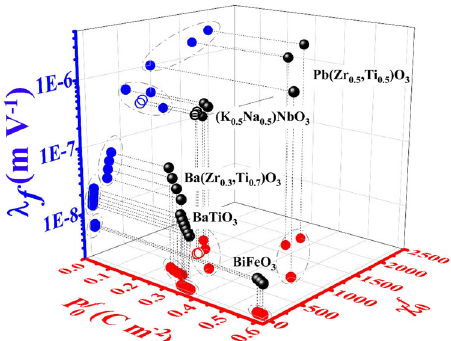
Fig. 1 Relationship between λ f , χ f 0 , and P f 0 . The relationship and P f of typical (001)-oriented tetragonal ferro- between λ f , χ f 0 0 electric fi lms, including BaTiO 3 , Ba(Zr 0.3 ,Ti 0.7 )O 3 , BiFeO 3 , K 0.5 Na 0.5 NbO 3 , and Pb(Zr 0.5 Ti 0.5 )O 3 . The two open-circle points are experimental data from this work. The ellipses are drawn for the guidance of the eye.